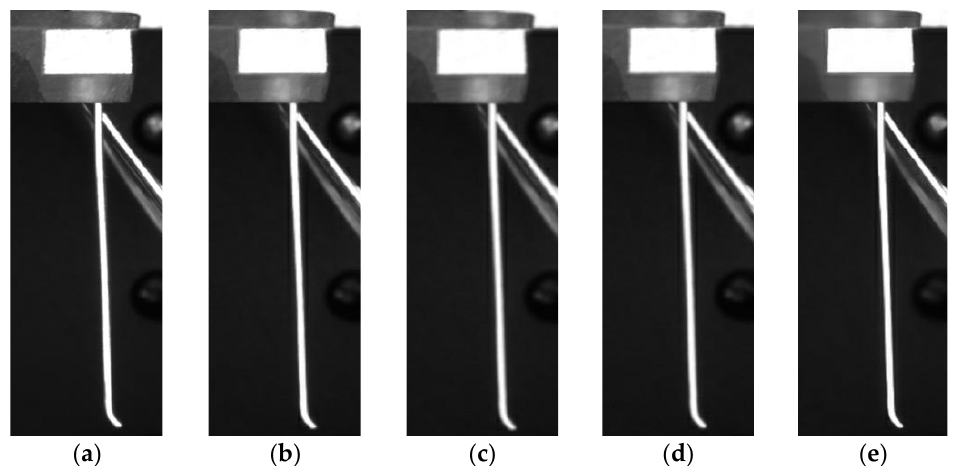
Figure 8. Brush filtration comparison images: ( a ) Original image and the ( b ) median, ( c ) mean, ( d ) Gaussian, and ( e ) bilateral filtering methods.